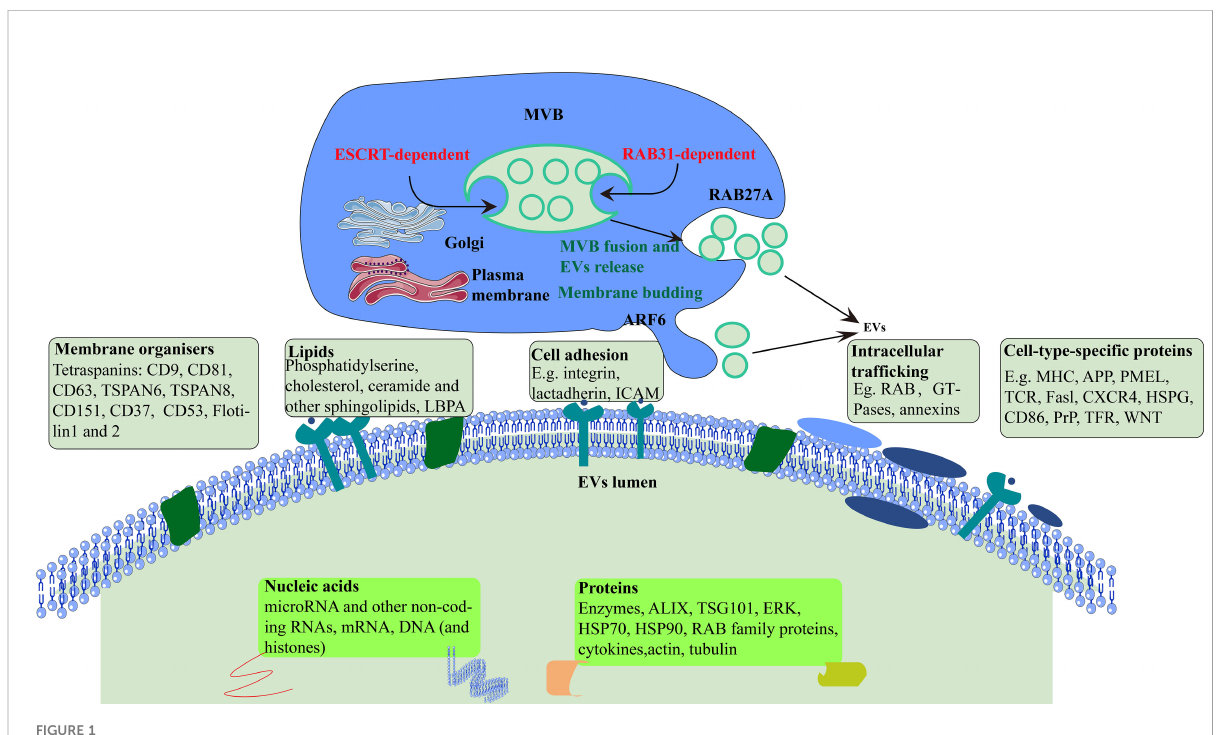
FIGURE 1 Formation and secretion of EVs. Cellular formation of EVs occurs either ESCRT-dependent or RAB31-dependent pathway. ARF6, ADP- ribosylation factor 6; TSPAN, tetraspanin; LBPA, lyso-bis-phosphatidyl acid; ICAM, intercellular adhesion molecule; MHC, major histocompatibility; APP, amyloid precursor protein; TCR, T cell receptor; CXCR4, CXC-chemokine receptor 4; HSPG, heparan sulfate proteoglycan; PrP, prion protein; TFR, transferrin receptor; TSG101, tumor susceptibility gene 101 protein; HSP70, heat shock 70 kDa protein; HSP90, heat shock 90 kDa